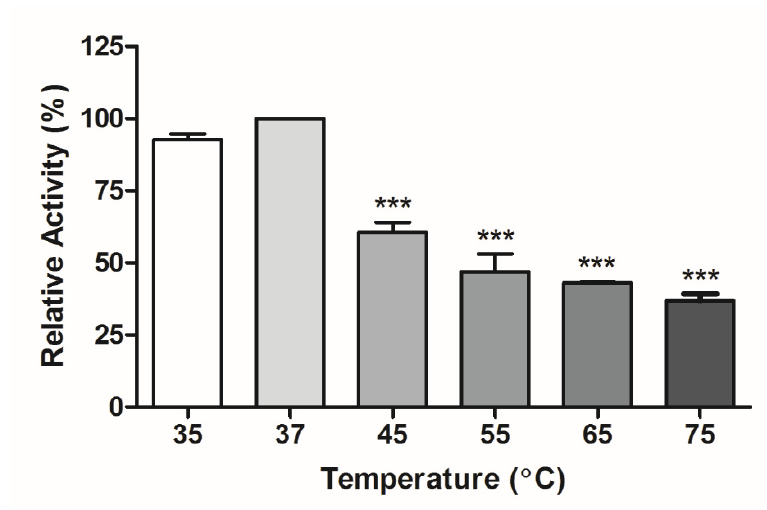
Figure 2. Effect of temperature on the enzyme activity of lipase. *** Significantly different values of control (37 °C), according to ANOVA followed by Dunnett’s post hoc test ( p < 0.0001). Mean and standard deviation.